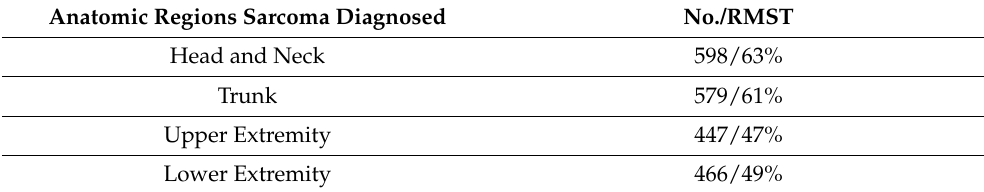
Table 3. RMST according to anatomic region.